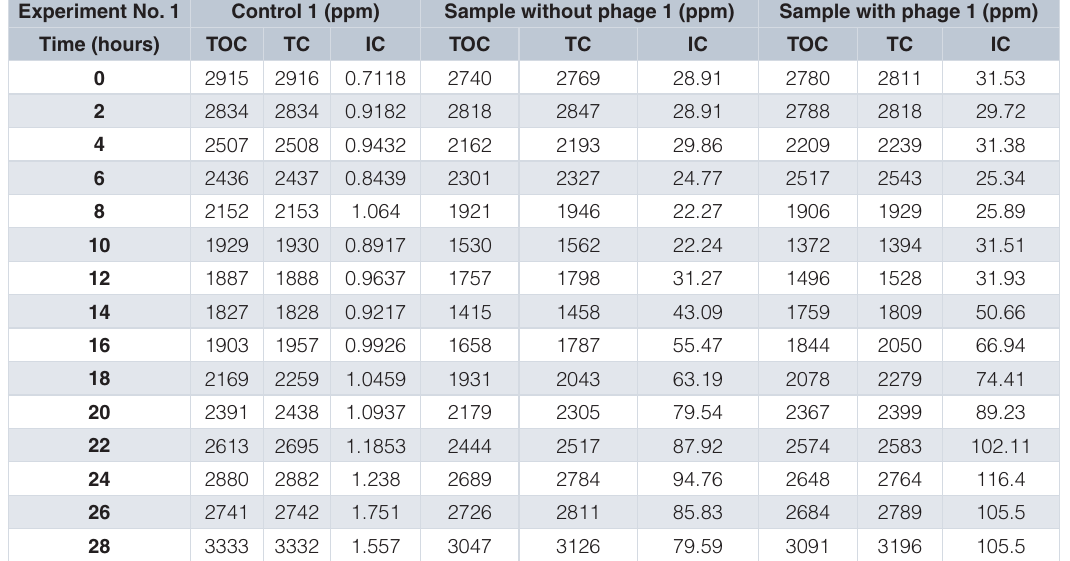
Table 1. TOC analysis results of control and bacterial samples (with and without phage). Experiment No.